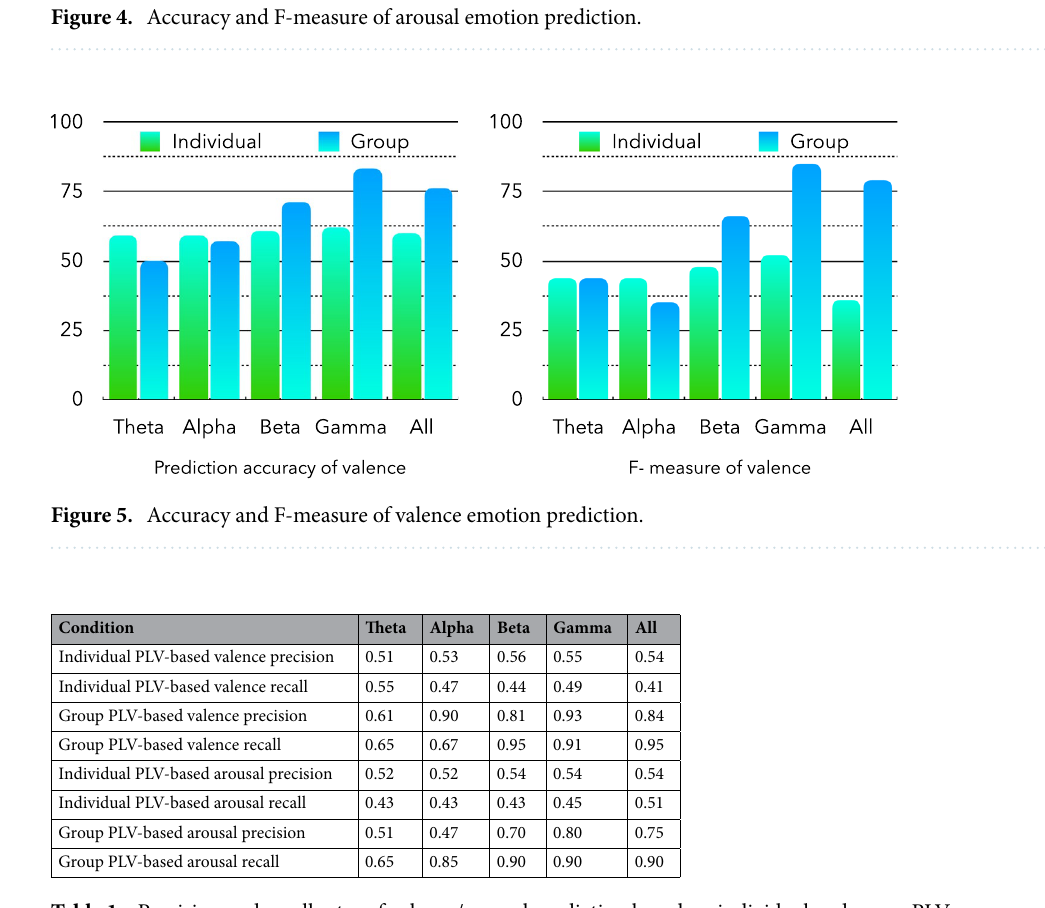
Table 1. Precision and recall rates of valence/arousal prediction based on individual and group